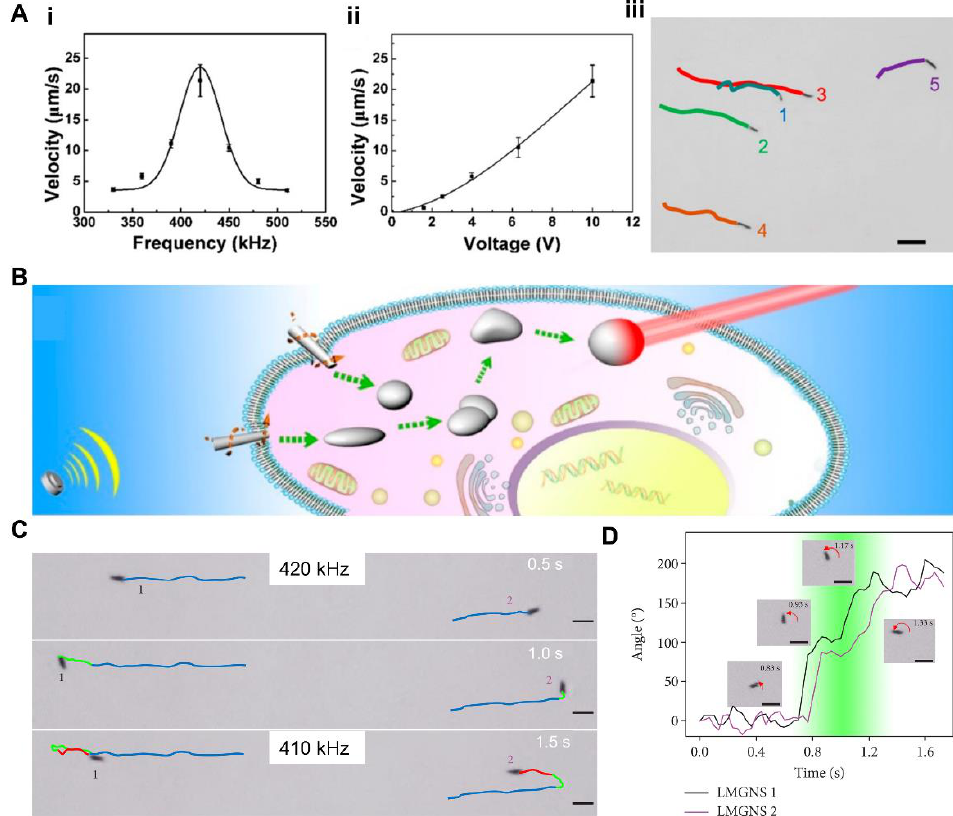
Figure 12. Ultrasound Field Induced Response. ( A ) Acoustically propelled liquid metal gallium nanomachine (LGNMs). (i) Average velocity of LGNMs under ultrasound of different frequencies (U = 10 V); (ii) Average velocity of LGNMs under different voltages at a frequency of 420 kHz; (iii) Time-lapse images of five LGNMs with different lengths. Reprinted with permission from [34]. Copyright 2018, American Chemical Society. ( B ) Schematic diagram of photothermal therapy achieved by acoustically propelled LGNMs. Reprinted with permission from [34]. Copyright 2018, American Chemical Society. ( C ) The time-lapse images of direction control of LMGNSs by frequency of ultrasound. Reprinted from Ref. [151]. ( D ) The motion direction changes during frequency changing. Reprinted from Ref. [151].